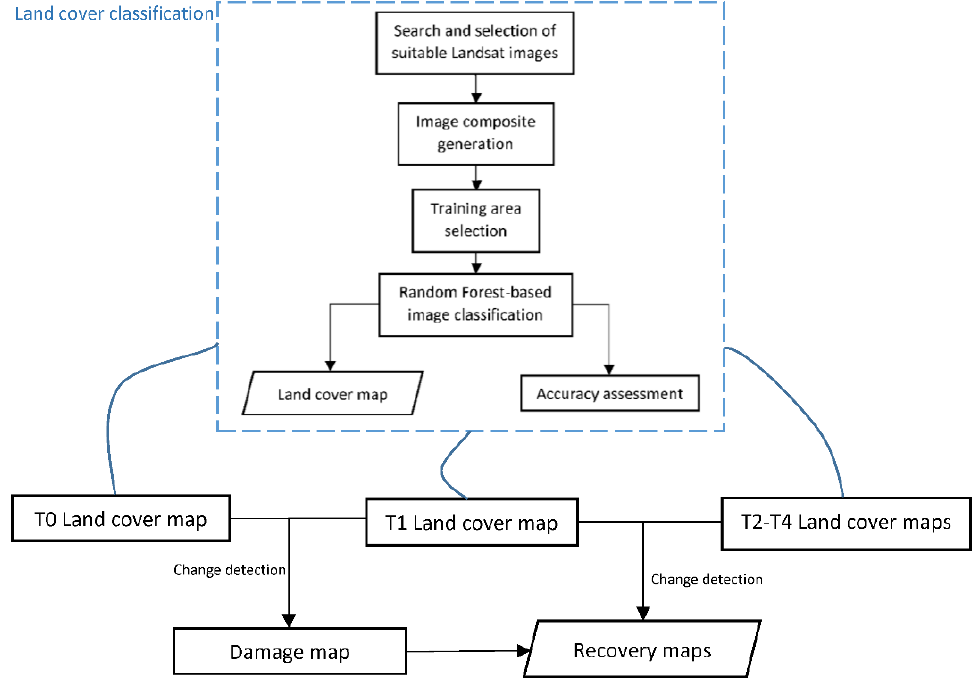
Figure 2. The proposed framework for post-disaster recovery monitoring.